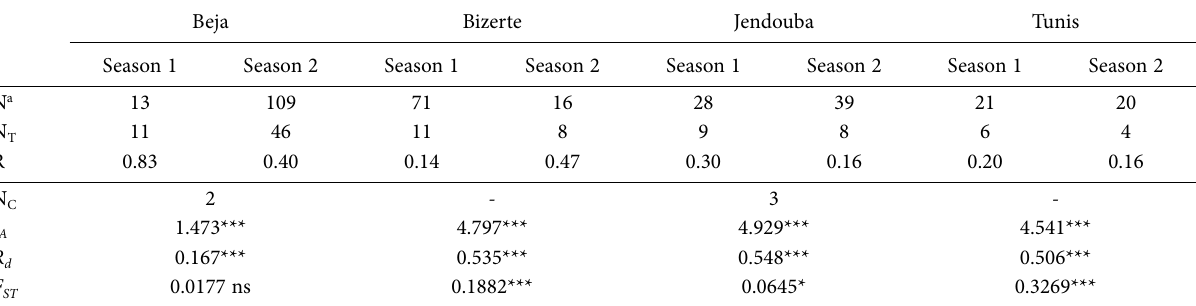
Table 7. Genetic differentiation, test for random mating ( I A , R d ), and pairwise genetic comparison F ST between two successive seasons at four Tunisian locations. Beja